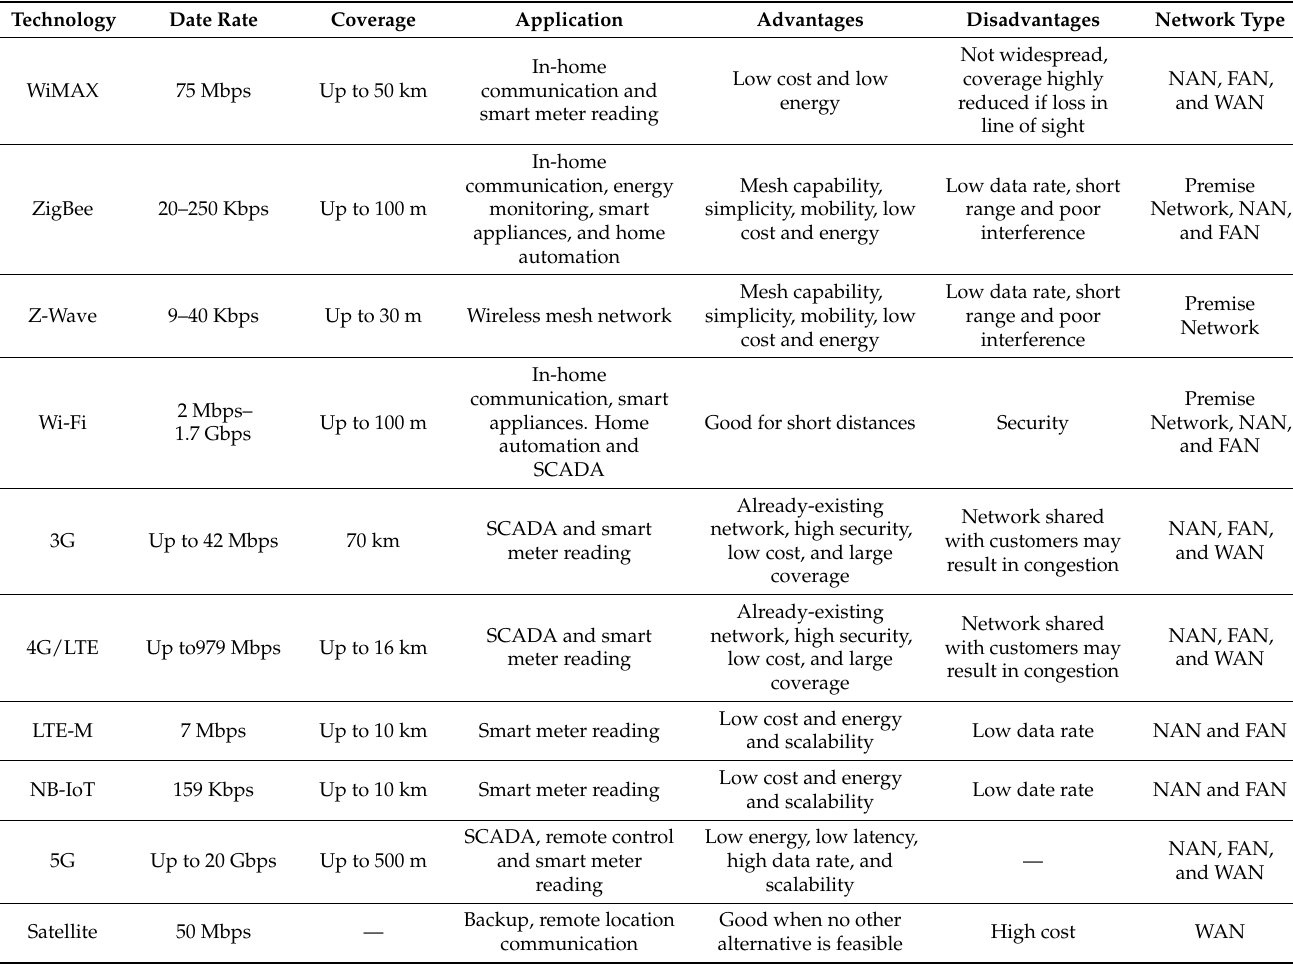
Table 3. Commonly used smart grid wireless communication